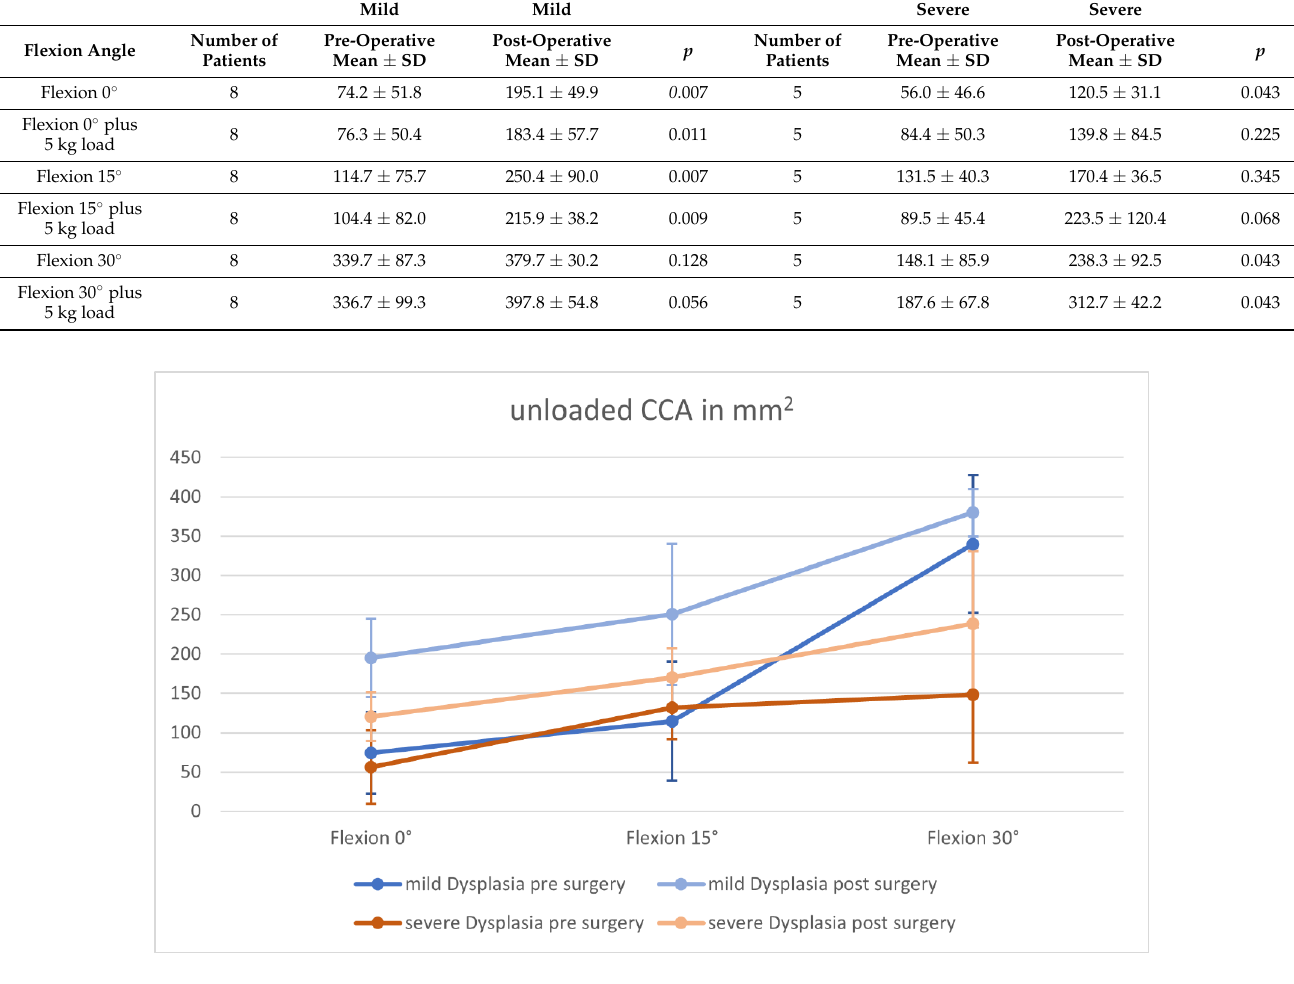
Figure 5. Changes in Cartilage Contact Area (CCA) without loading.